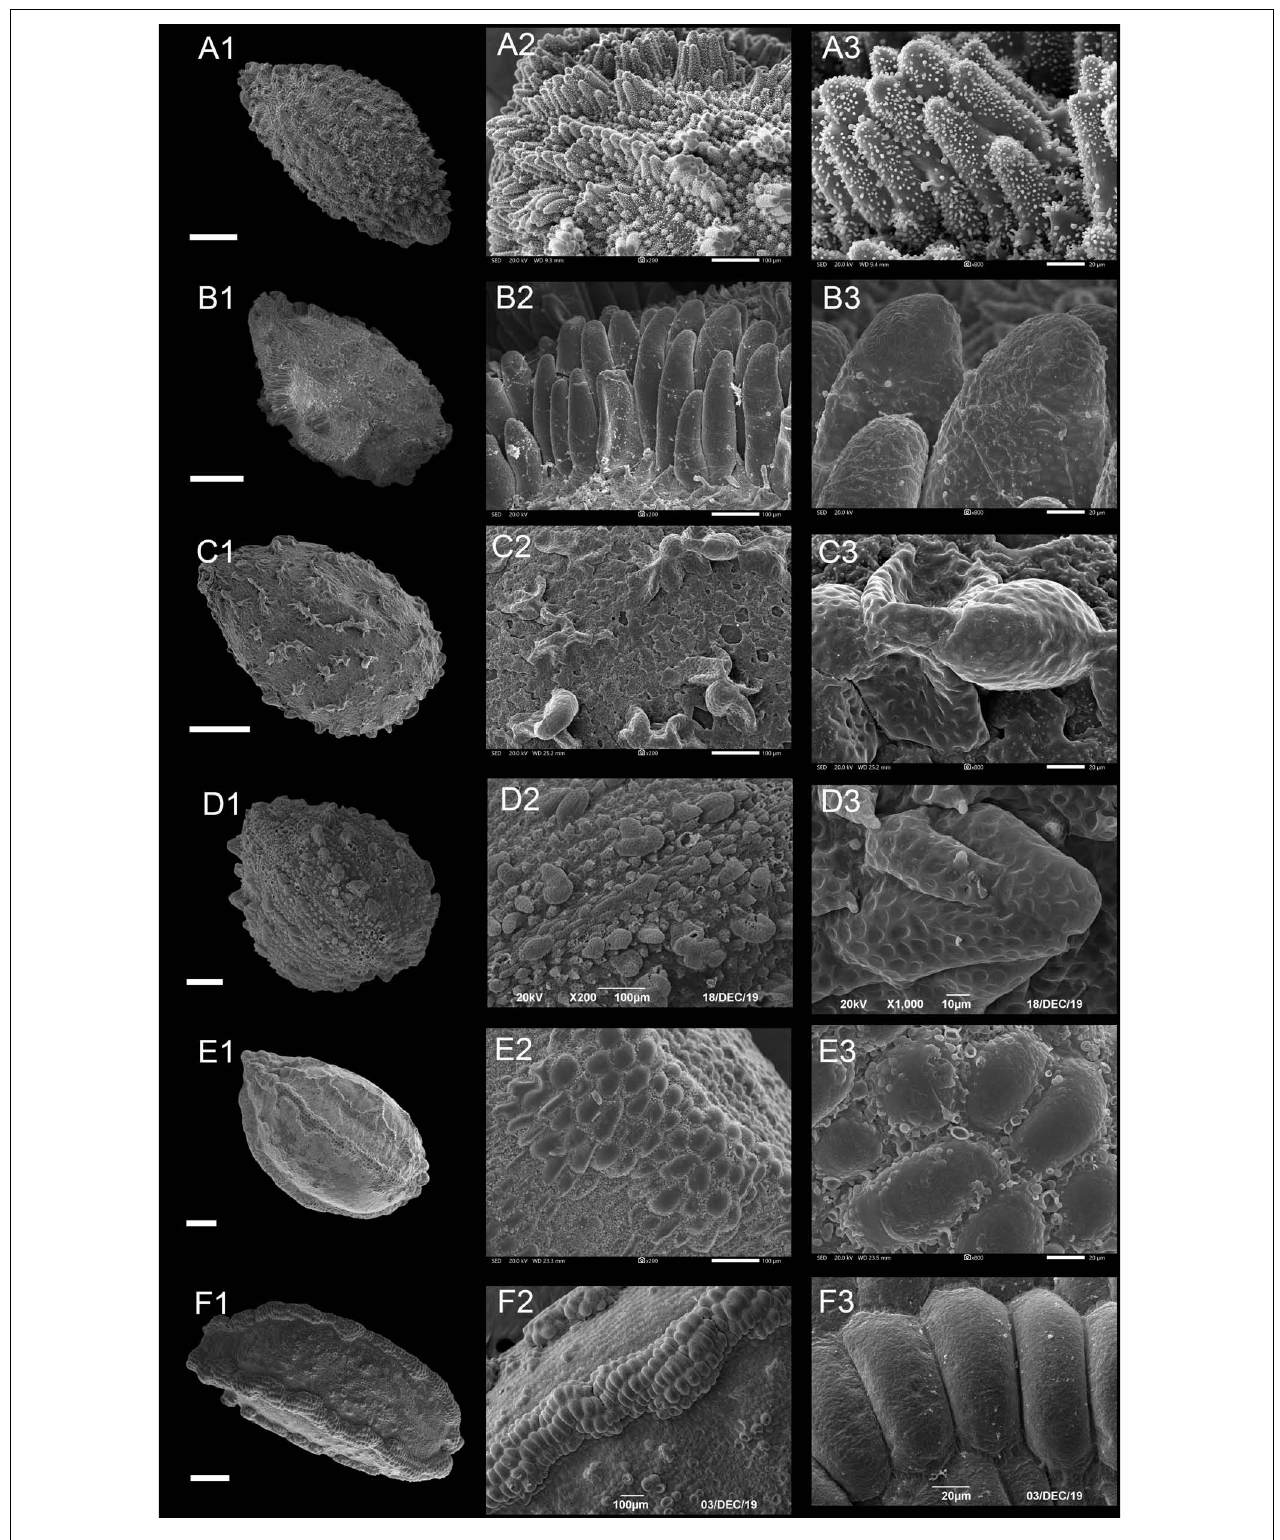
FIGURE 4 | Scanning electron microscope images of seeds from protrusive type of Impatiens . (A1–F1) Whole view; (A2–F2,C3–F3) Partial view. (A1–A3) Impatiens huangyanensis , (B1–B3) Impatiens cyathiflora , (C1–C3) Impatiens principis , (D1–D3) Impatiens drepanophora , (E1–E3) Impatiens longialata , (F1–F3) Impatiens noli-tangere . Scale bars: (A1–C1,E1,F1) = 500 µ m, (D1) = 200 µ m.